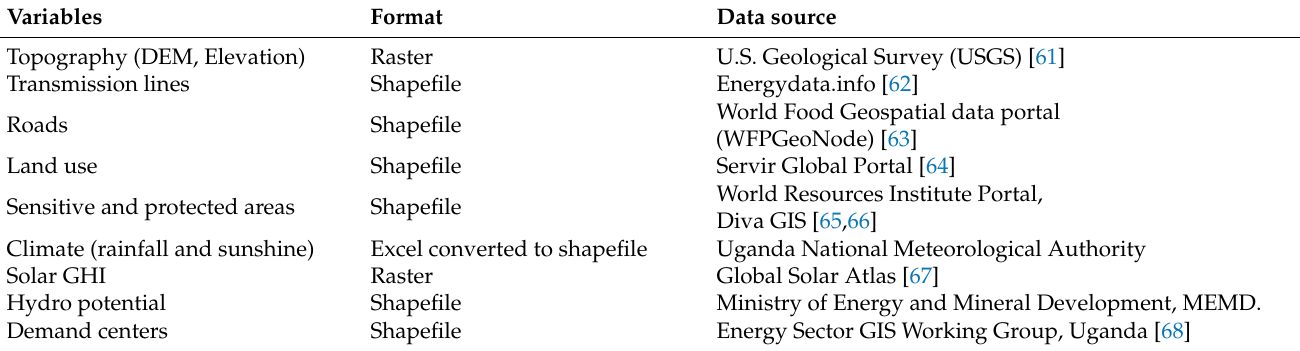
Table A1. Data and sources.